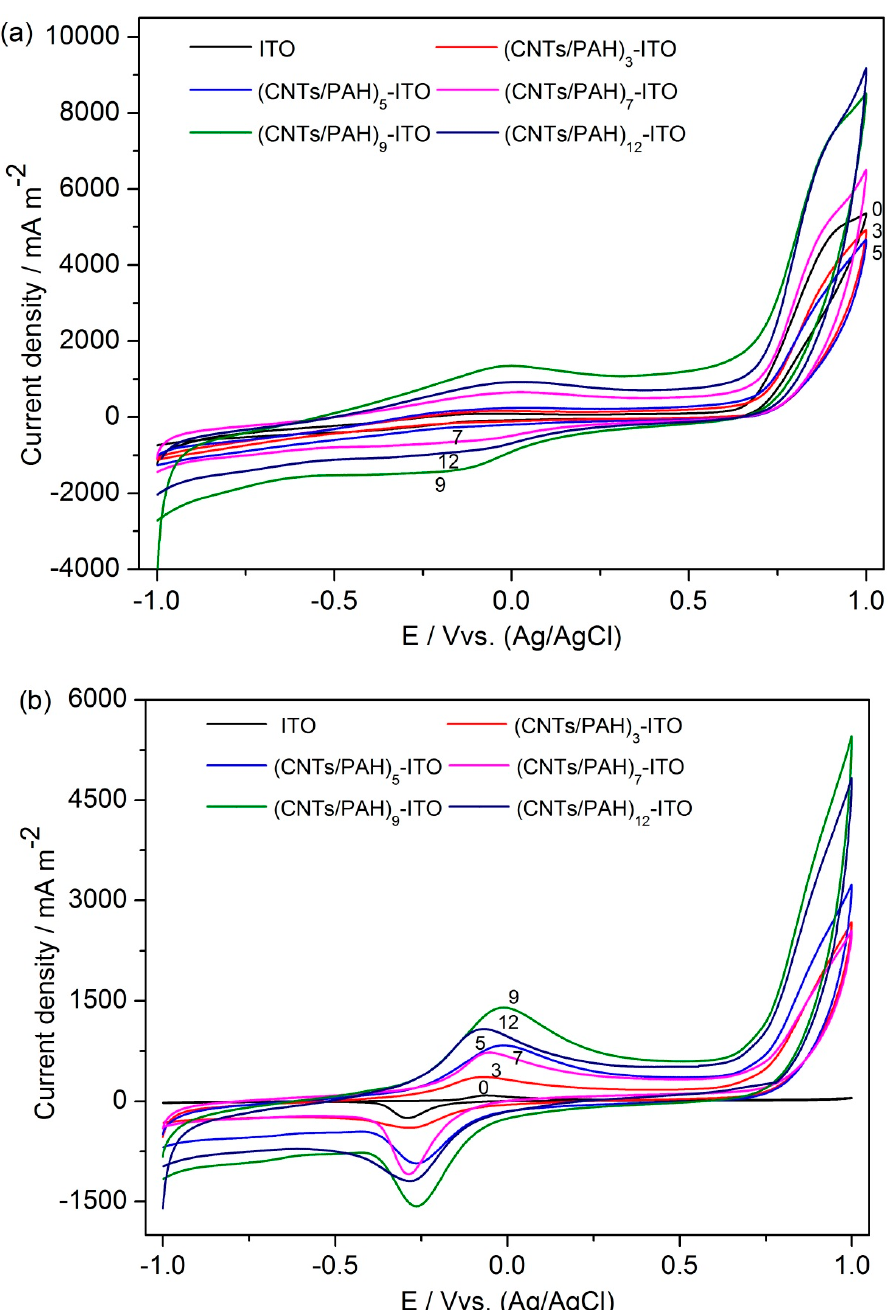
Figure 4. Cyclic voltammetry (CV) of the (CNTs/PAH) n -deposited ITO electrode (n = 0, 3, 5, 7, 9, 12) before ( a ) and after ( b ) 25 h of chronoamperometry at a scan rate of 100 mV/s.